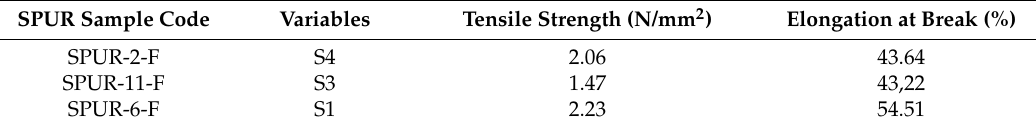
Table 10. The mechanical test results of cured SPUR with different silanes.